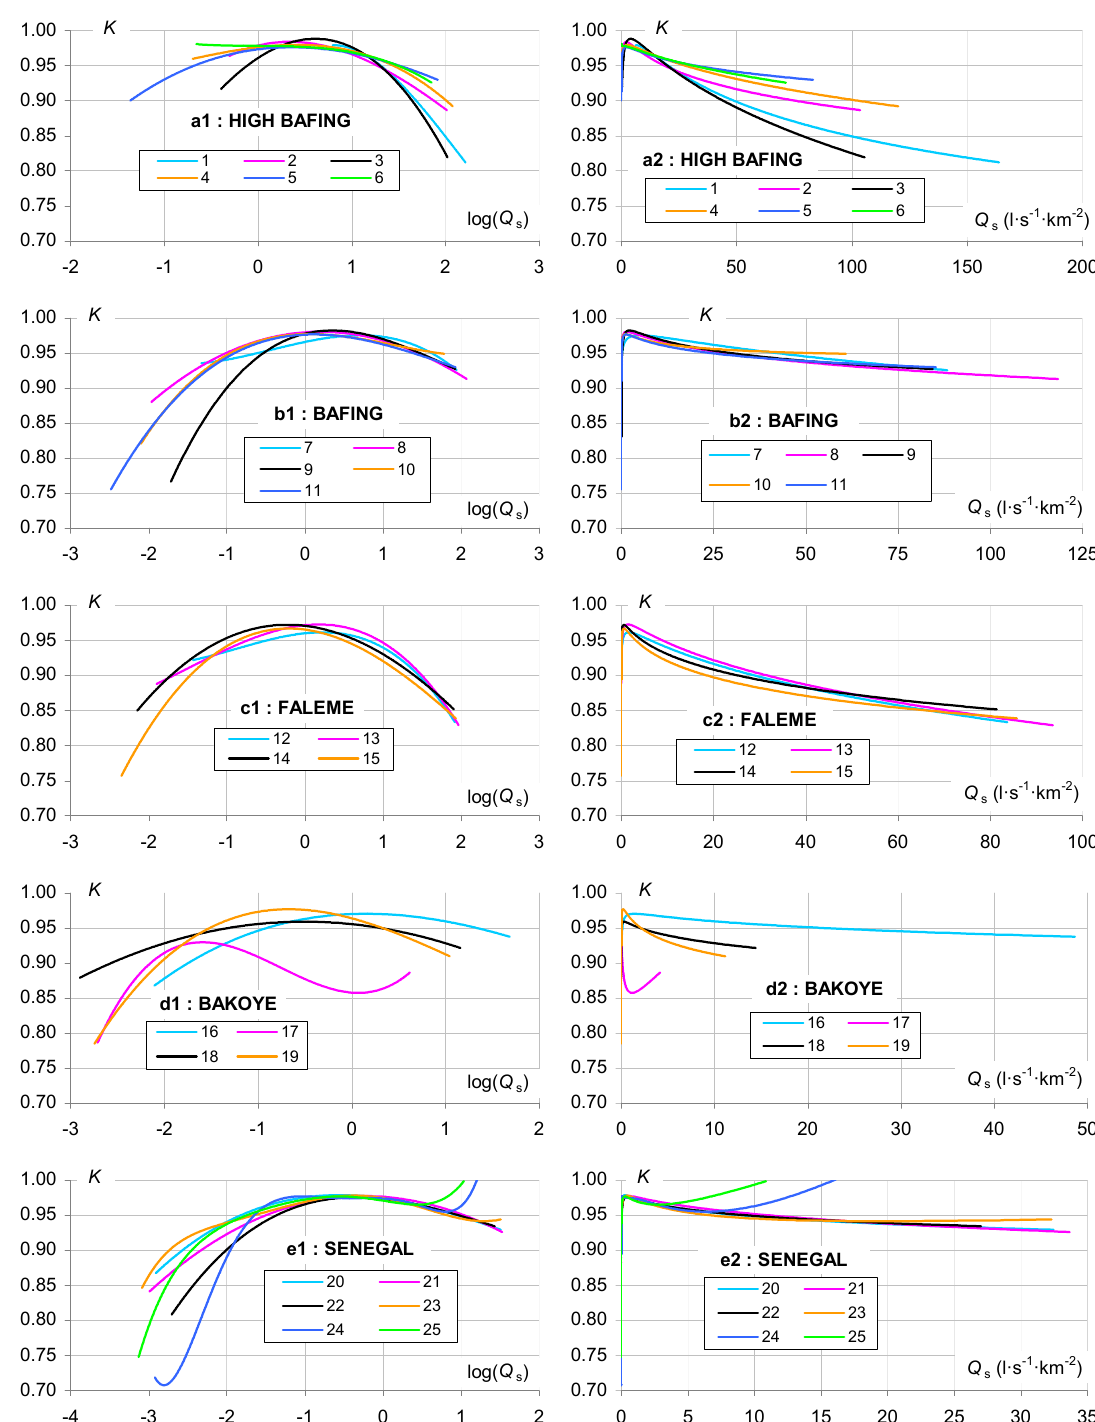
Figure 7. Model 2 representing K as a function of the specific discharge Q s at the 25 stations located in the Senegal basin (relations K = g ( Q )), with abscissa in logarithmic values on the left (index 1) and natural values on the right (index 2), by sub-basins: High Bafing ( a1 , a2 ), Bafing ( b1 , b2 ), Faleme ( c1 , c2 ), Bakoye ( d1 , d2 ), Senegal ( e1 , e2 ).